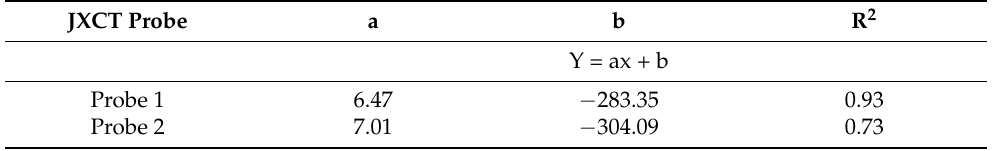
Table 7. Fitting and determination coefficient for the JXCT probes when increasing the nitrate concentration in sand at 35% volumetric soil